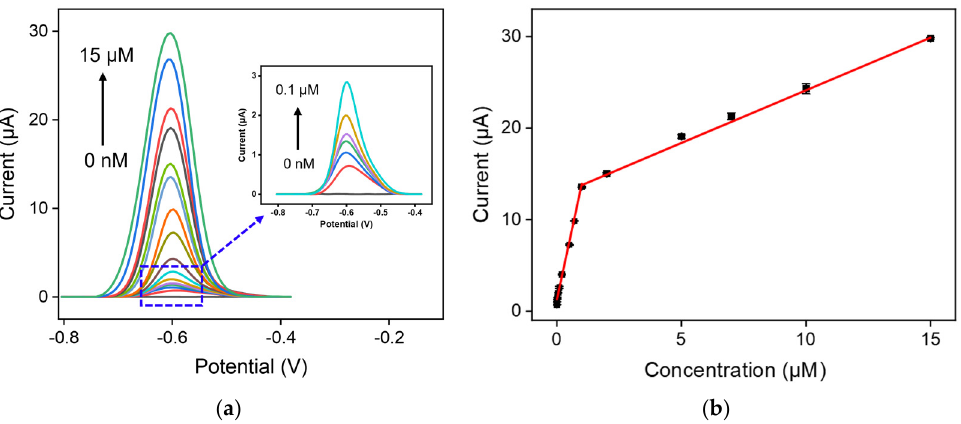
Figure 5. ( a ) DPV curves and ( b ) the calibration curve of VMSF/ErGO/SPCE in 0.1 M PBS solution (pH 6.0) containing DOX ranging from 0 nM to 15 μ M (0, 0.002, 0.005, 0.01, 0.02, 0.05, 0.1, 0.2, 0.5, 0.7, 1, 2, 5, 7, 10, and 15 μ M). Inset in ( a ) is the amplified view of the DPV curves in the low-concentration region and the potential ranged from − 0.8 V to − 0.4 V. The error bars in ( b ) represent the standard deviations of three measurements. Table 1. Comparison of the analytical performances of different modified electrodes for the determination of DOX.